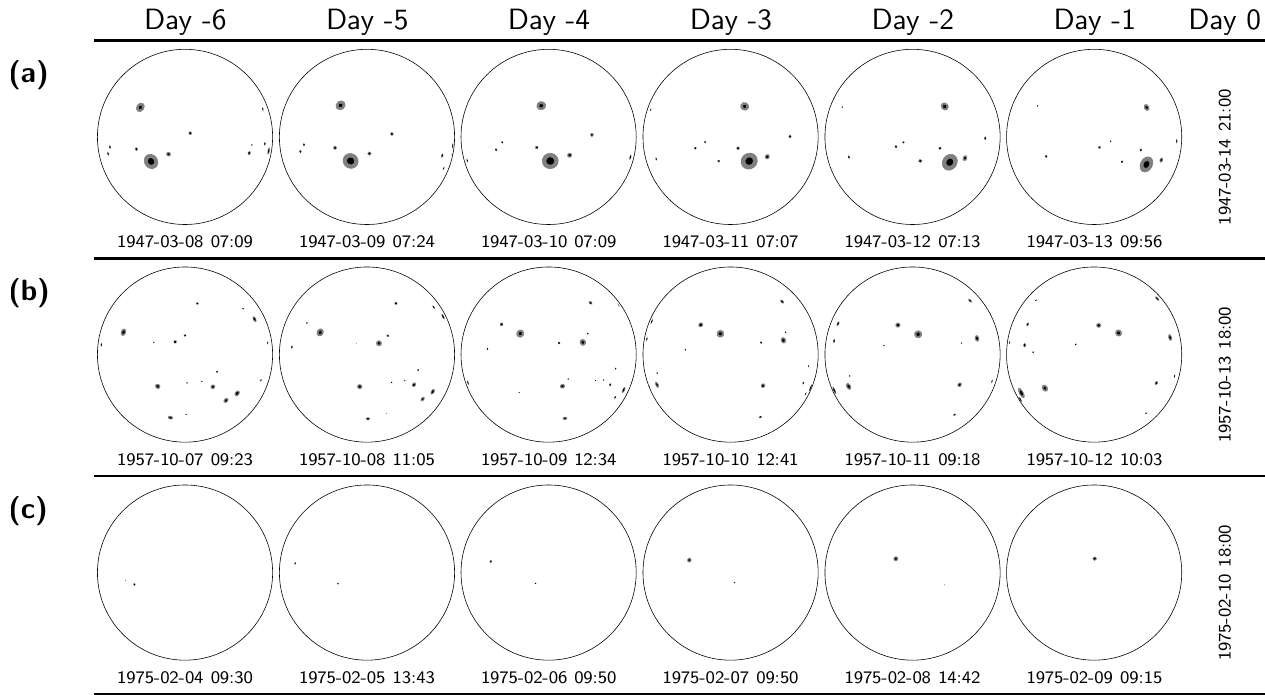
Fig. 1. Reconstructed solar images for the six-day intervals immediately before the major geomagnetic storms that commenced on: (a) 1947 March 14; (b) 1957 October 13; and (c) 1975 February